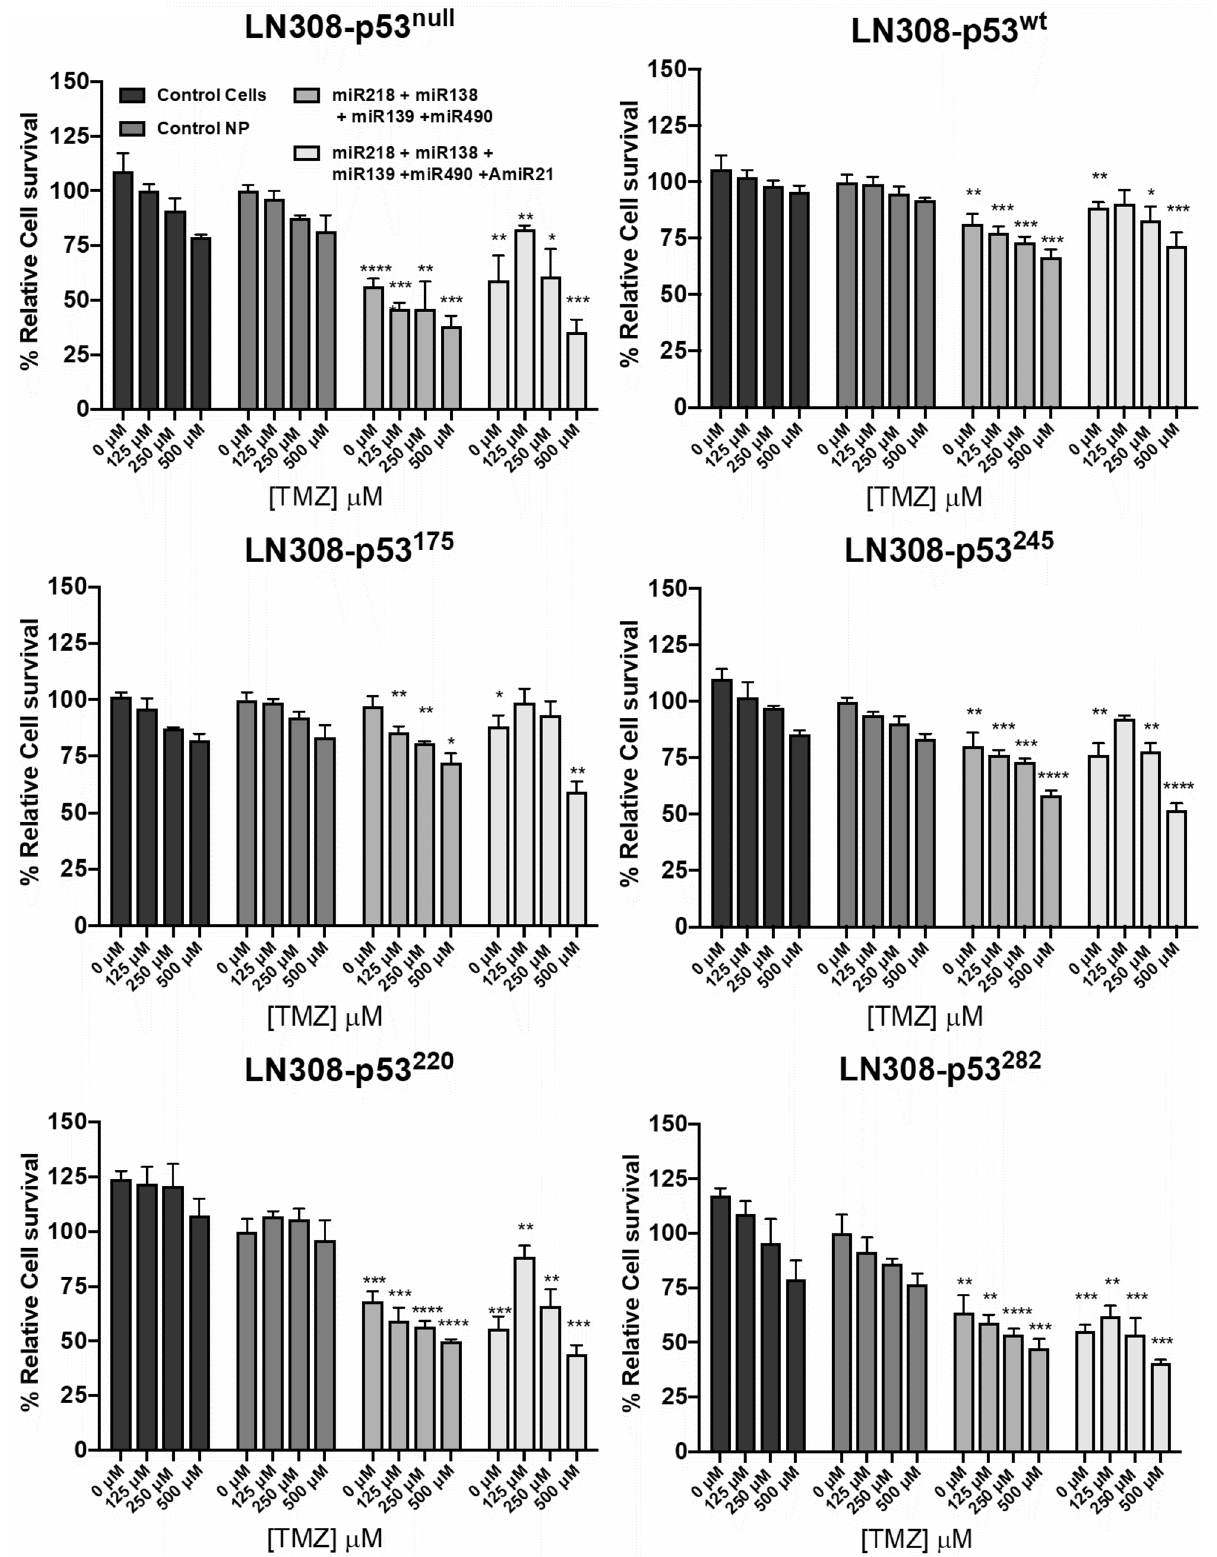
Figure 5. MTT and western blotting assays on LN308 cell line with different p53 variant phenotypes. MTT assay to show the cell viability of LN308 cell lines engineered to express structurally mutant p53 proteins. Each condition was repeated in triplicates. Error bars show standard deviations. Asterisks show significant difference compared to cells treated with control NPs of the corresponding dose where, *represent p -value < 0.05, **represent p‑ value < 0.01, ***represent p‑ value < 0.001, ****represent p‑ value <